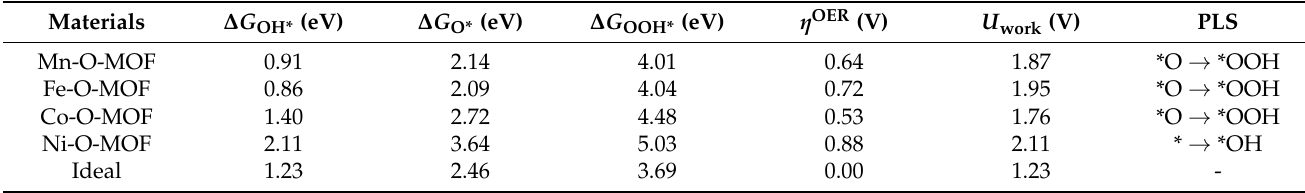
Table 2. Computed adsorption free energies of *OH, *O, and *OOH ( ∆ G *OH , ∆ G *O , ∆ G *OOH ), OER overpotentials ( η OER ), working potentials ( U work ), and corresponding potential-limiting step (PLS) on TM-O MOF